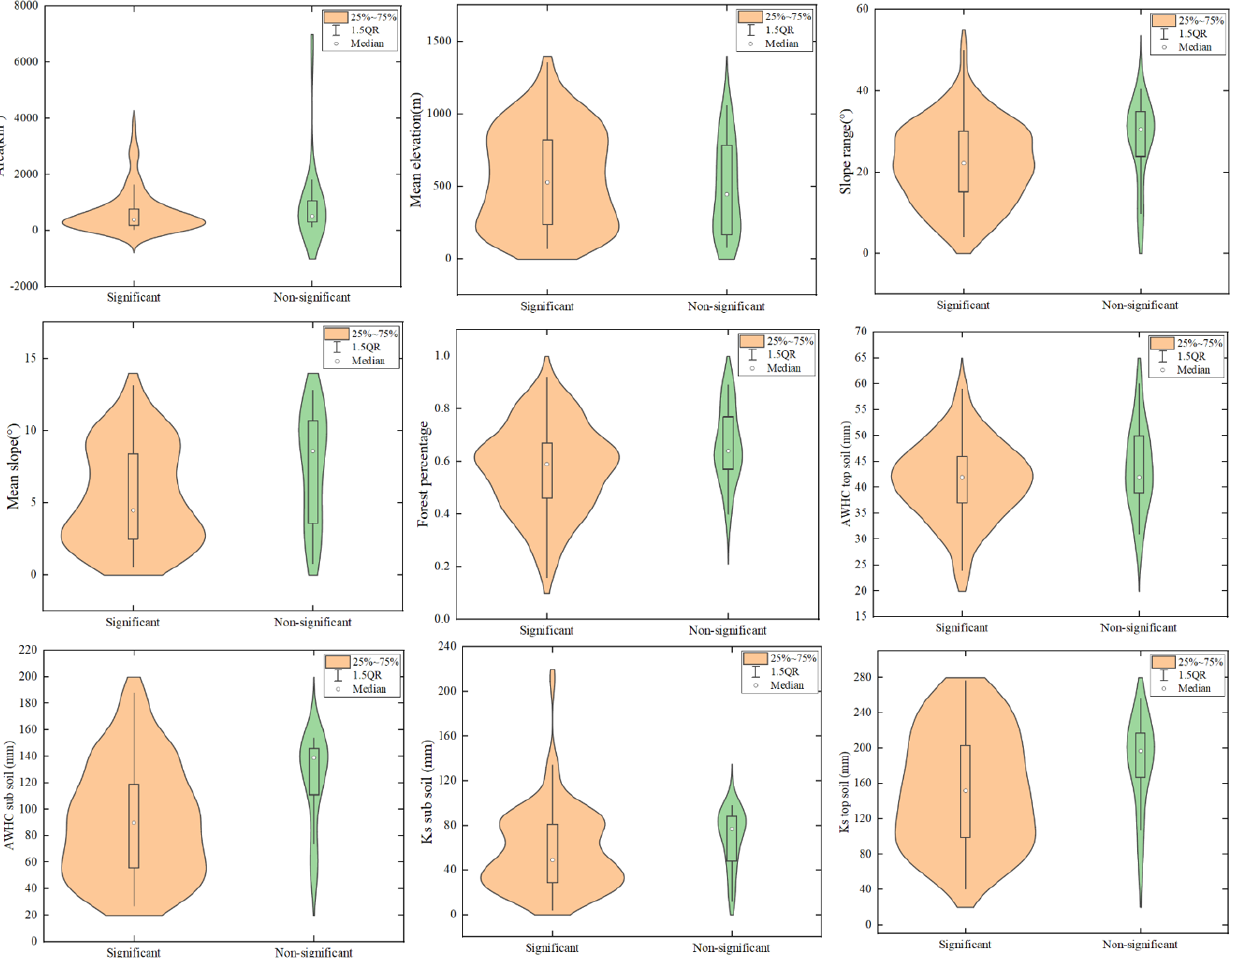
Figure 10. Comparison of catchment characteristics between the groups of catchments with significant and nonsignificant changes in mean value δ , i.e., the g δ ( S ) and g δ ( NS )